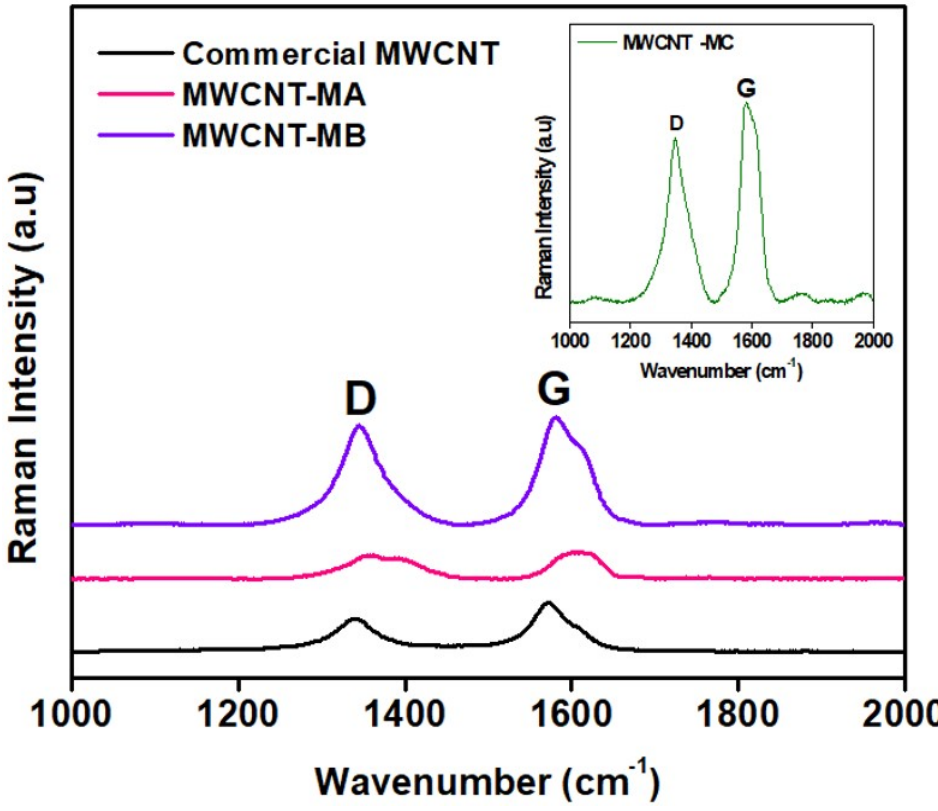
Figure 2. Raman spectrum of commercial and surface oxidized MWCNTs. Table 4. The value of I D /I G ratio for commercial and surface oxidation of MWCNTs.